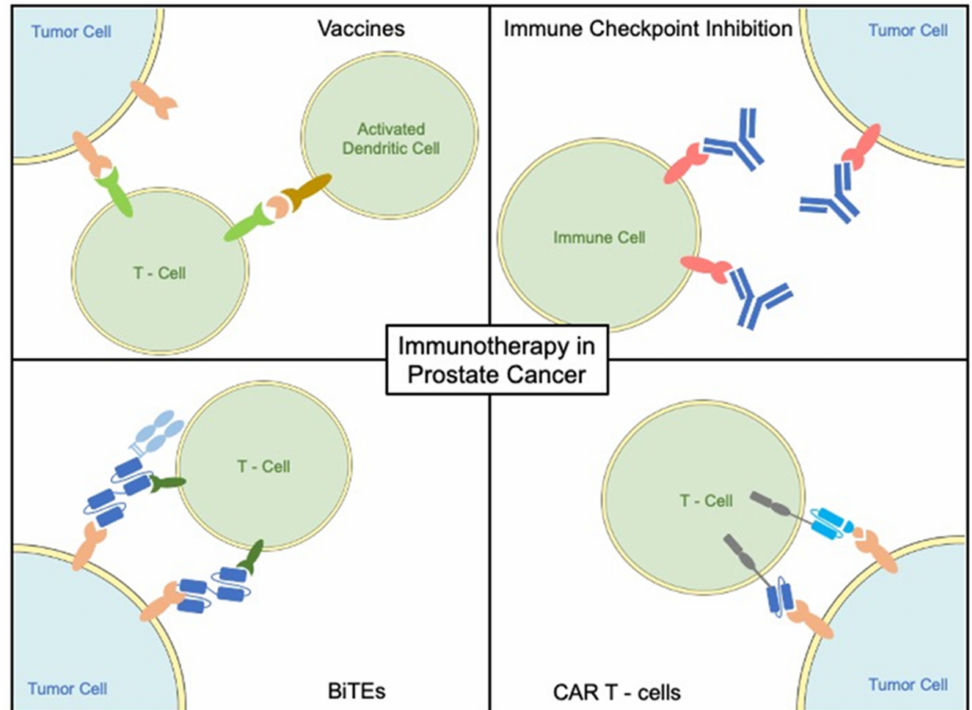
Figure 2. Immunotherapeutic approaches in advanced prostate